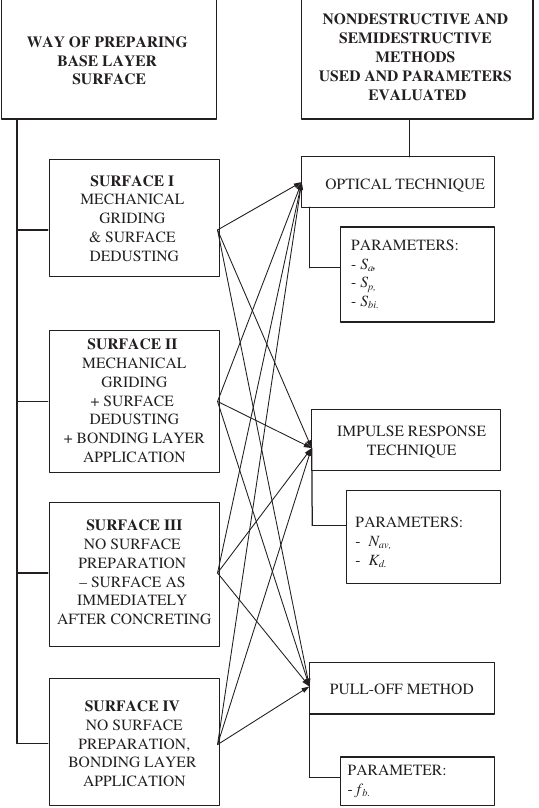
Fig. 8. Combinations of ways of preparing base layer surface and non-destructive and semi-destructive methods with evaluated parameters